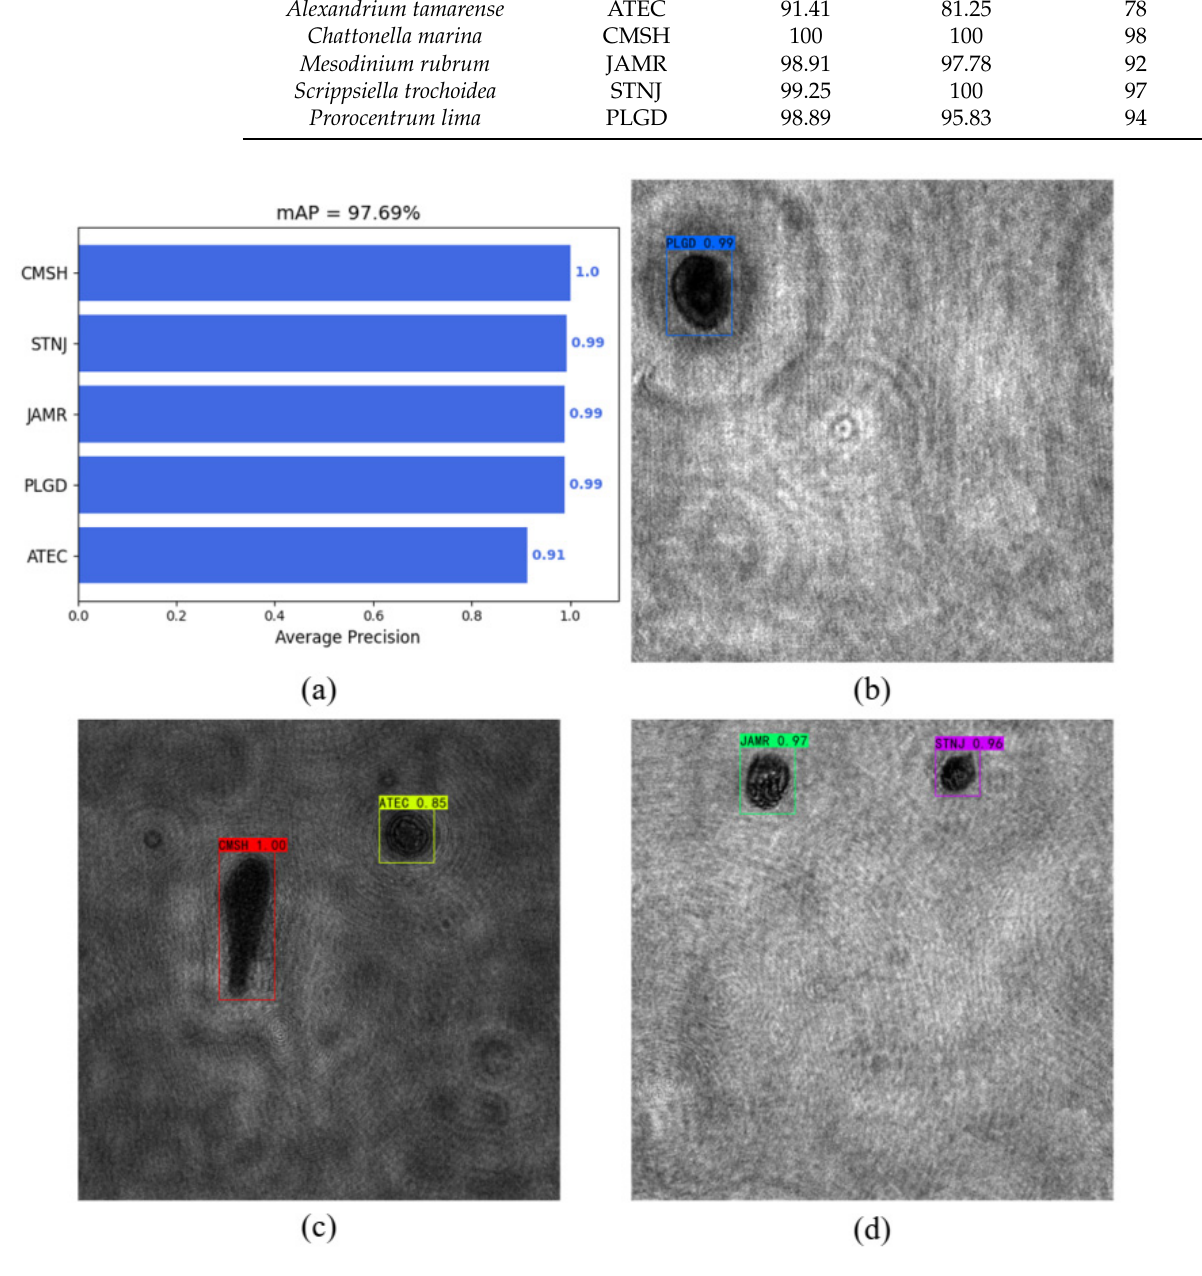
Figure 8. The results of YOLOv4, ( a ) mAP of YOLOv4, ( b ) the detection of PLGD, ( c ) the detection of CMSH and ATEC, and ( d ) the detection of JAMR and